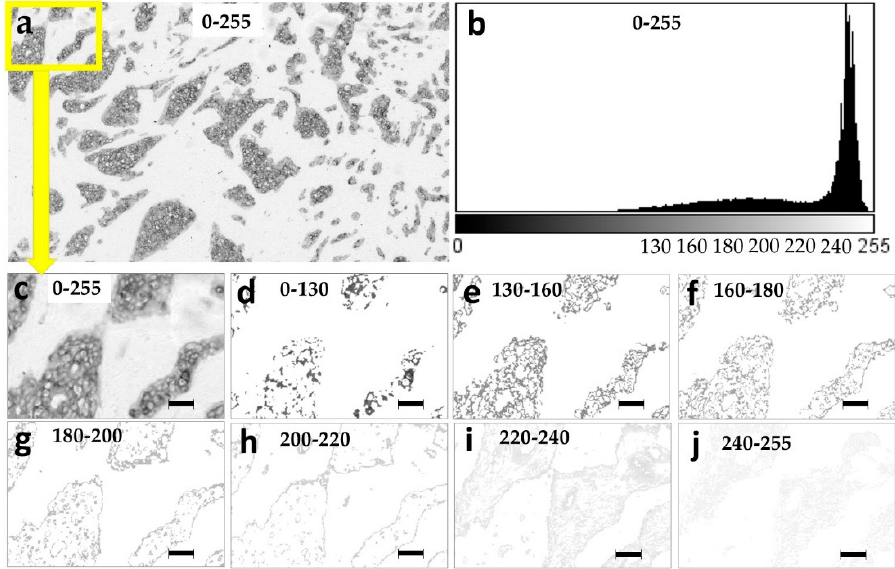
Figure 1. Grey level slicing of the exemplary breast tumor tissue section stained with pan cytokeratin. ( a ) Original image with the full 0–255 pixel intensity range, ( b ) intensity histogram of the original 0–255 spectrum with pixel intensity on the x axis versus a number of pixels on the y axis. Magnified inserts of the original image show: ( c ) the original grey level range of 0–255, ( d ) 0–130 grey level range, ( e ) 130–160, ( f ) 160–180, ( g ) 180–200, ( h ) 200–220, ( i ) 220–240, and ( j ) 240–255 grey level ranges. Magnification in ( c – j ): ×200. Pixel size: 1.4 µm. Bar 50 µm, indicated in images 2c–j.